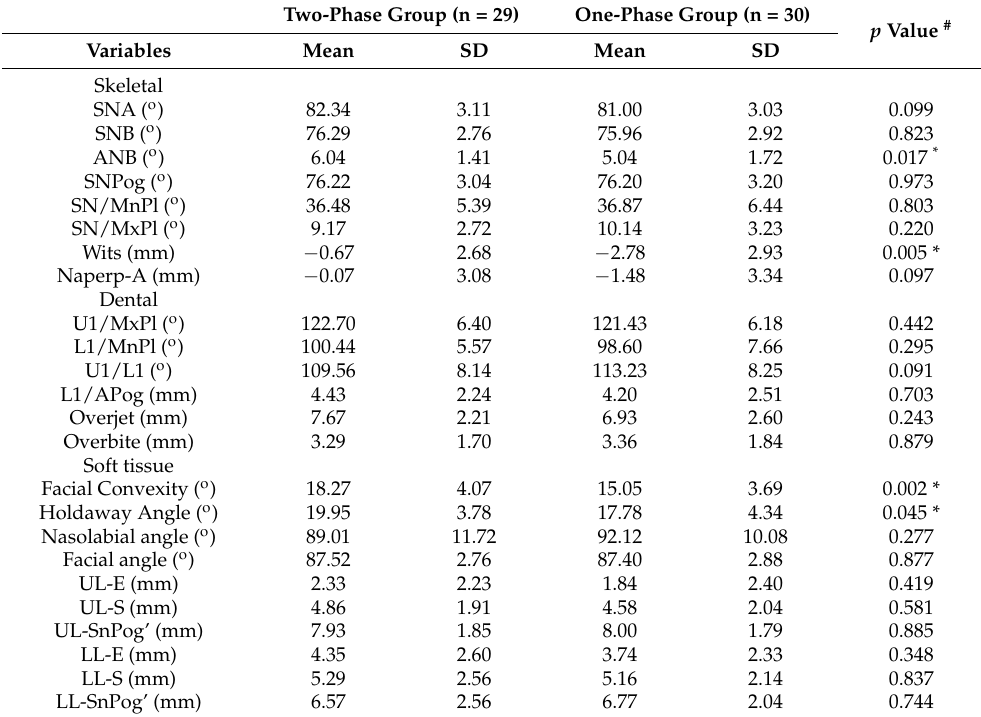
Table 3. Comparison of pre-treatment cephalometric